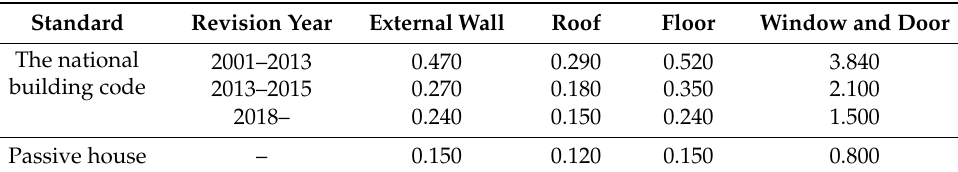
Table 3. The national standard for building envelope by year and passive house standard for the building envelope (unit: W / m 2 K).